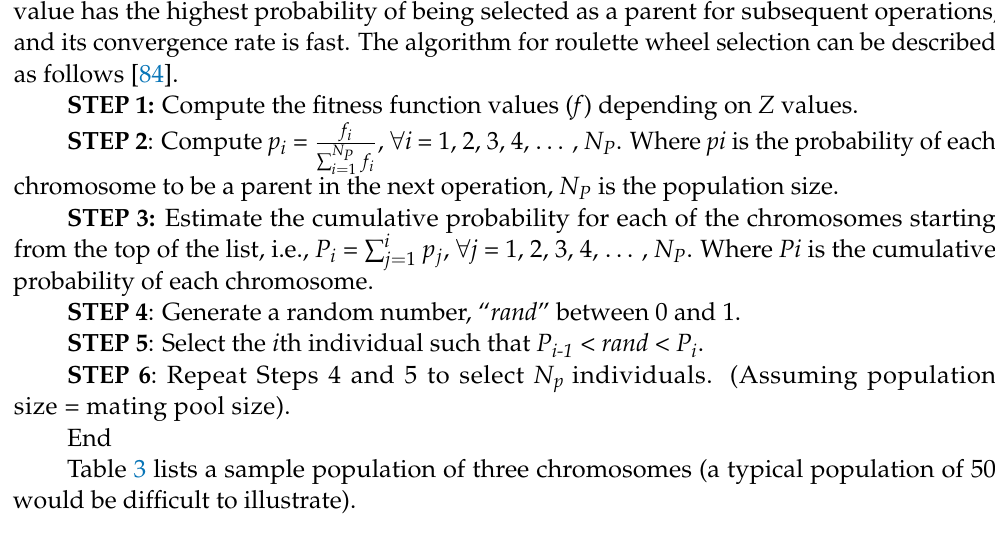
Table 3. Example for roulette wheel